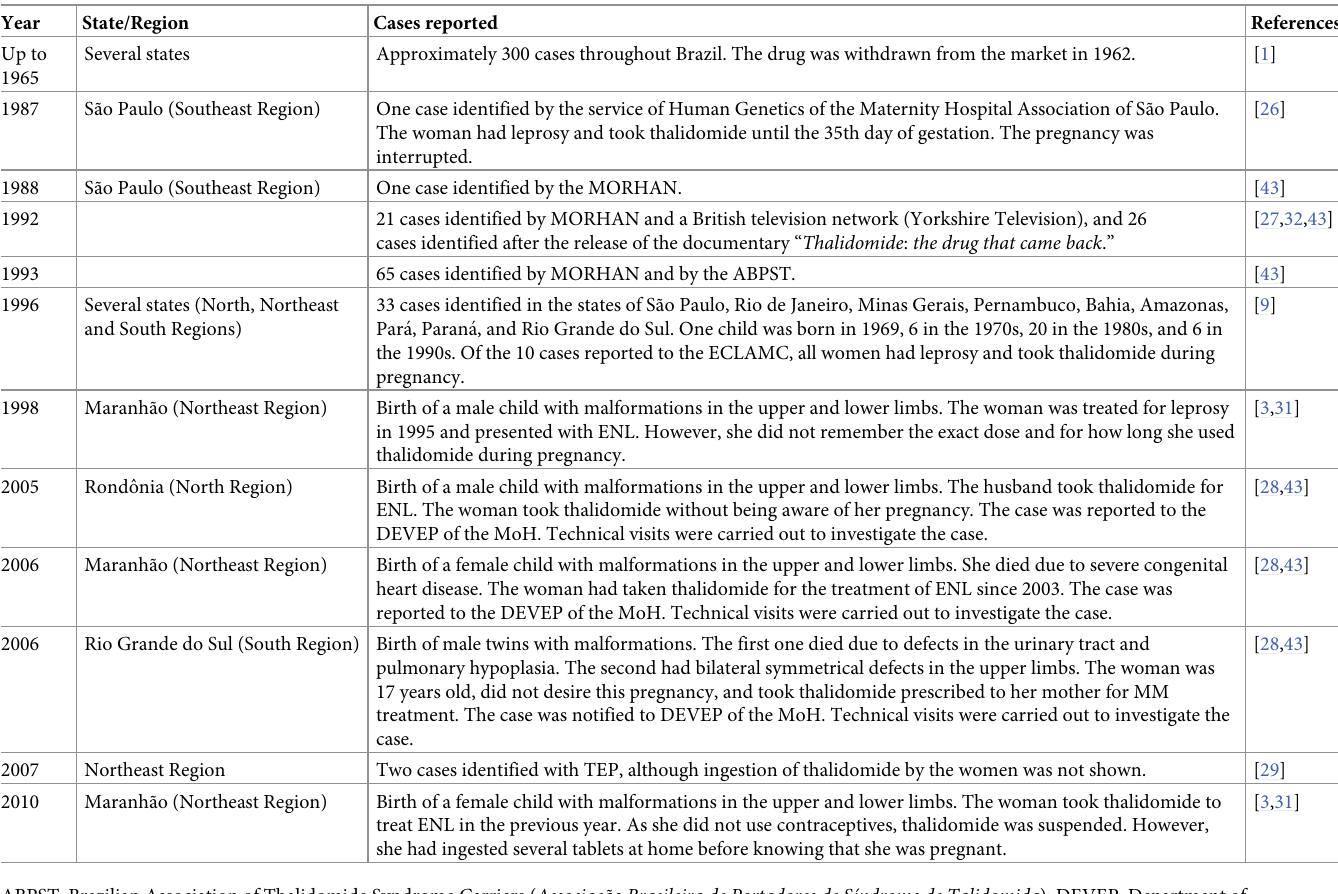
Table 2. Reported cases of embryopathy registered in Brazil, from 1965 to